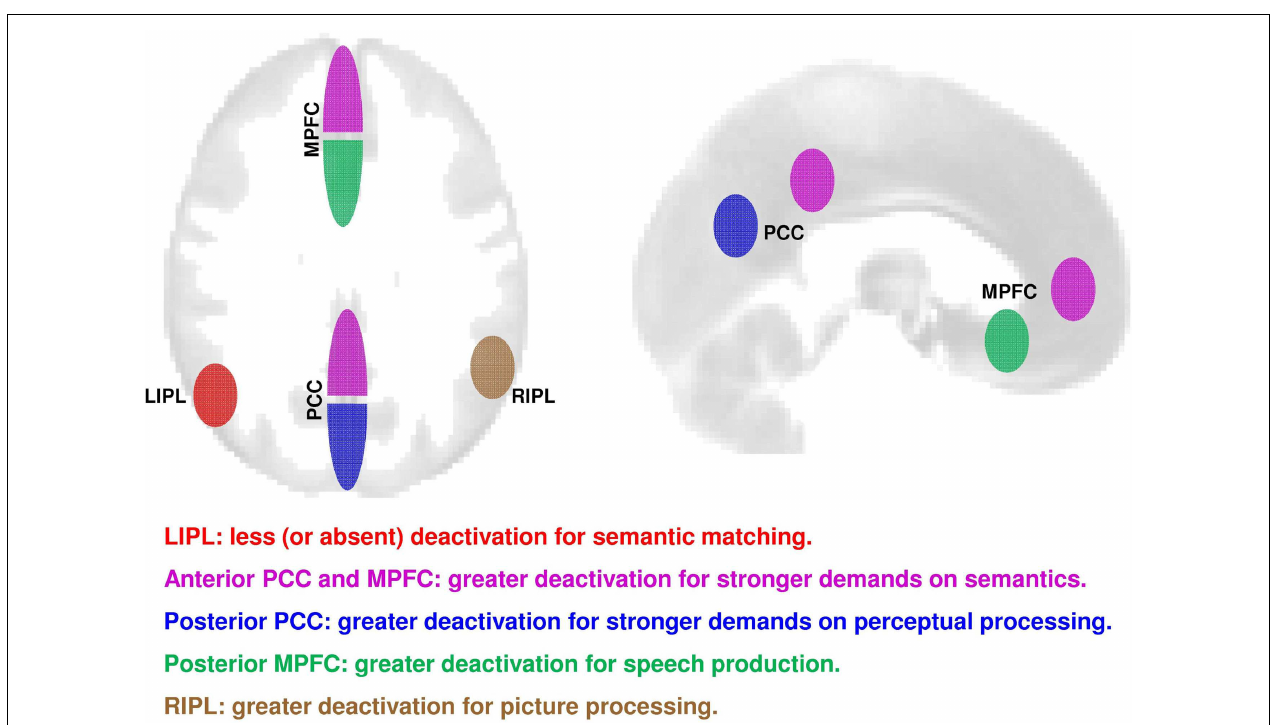
“123” > PM). In green: greater deactivation during speech production over both familiar and unfamiliar stimuli (contrast = matching > production). In brown = greater deactivation for pictures of objects than to written words (contrast = words > pictures). PCC, precuneus and posterior cingulate cortex; MPFC, medial prefrontal cortex; LIPL, left inferior parietal lobule; RIPL, right inferior parietal